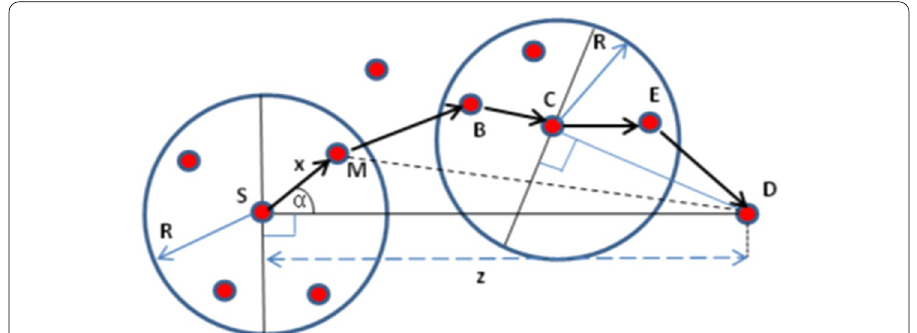
Fig. 1 Multi-hop packet forwarding